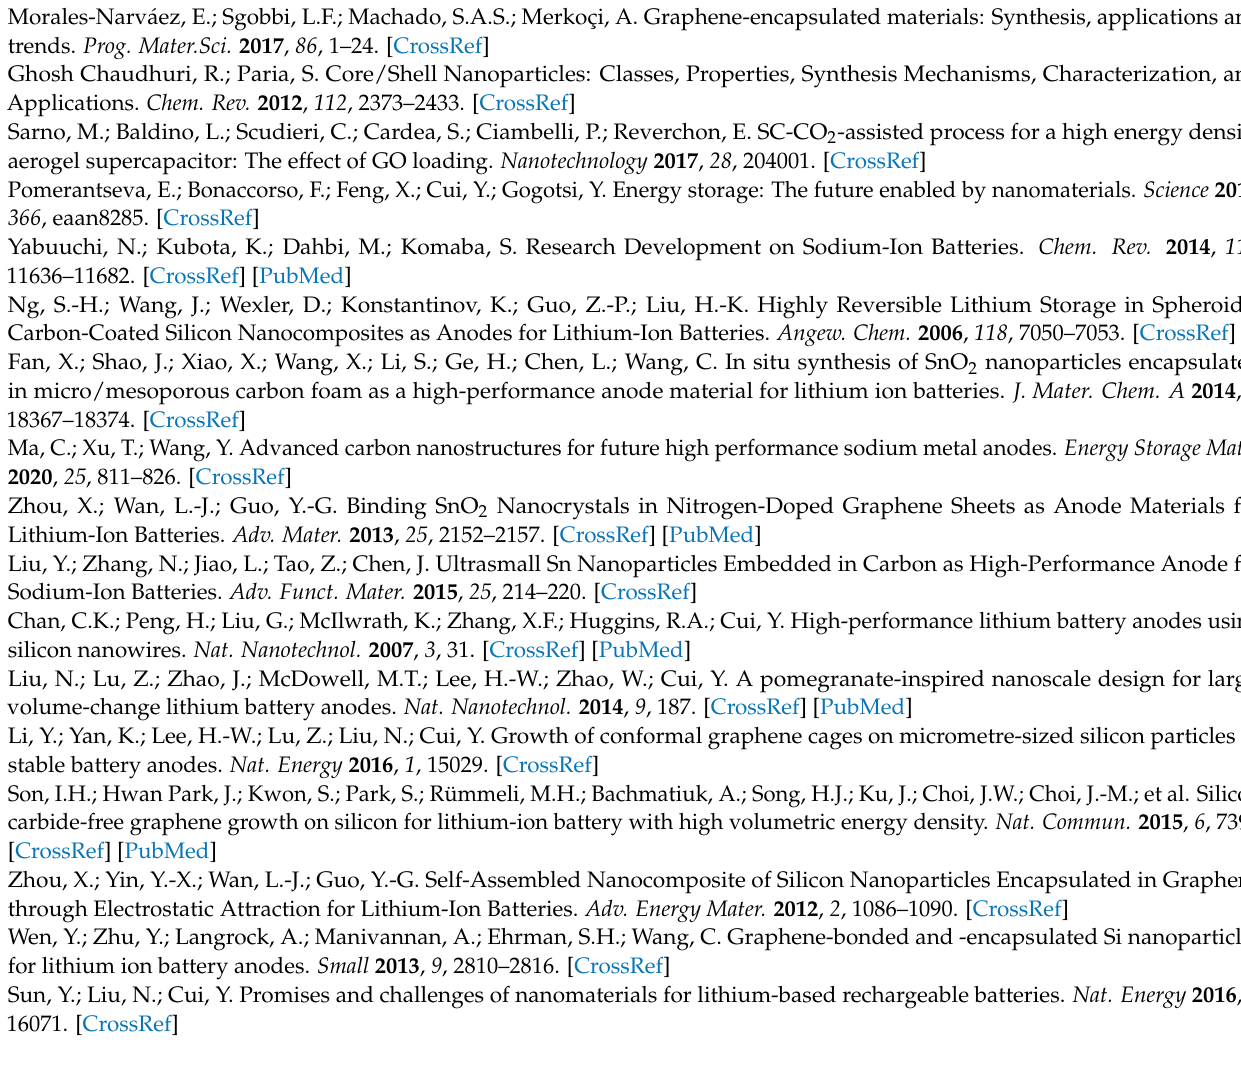
Figure S4: Curve of the pressure versus time of 0.5g of 70PTFE-30Si (wt.%) in closed bomb with 220 mL internal volume. The size of Si particles is 500